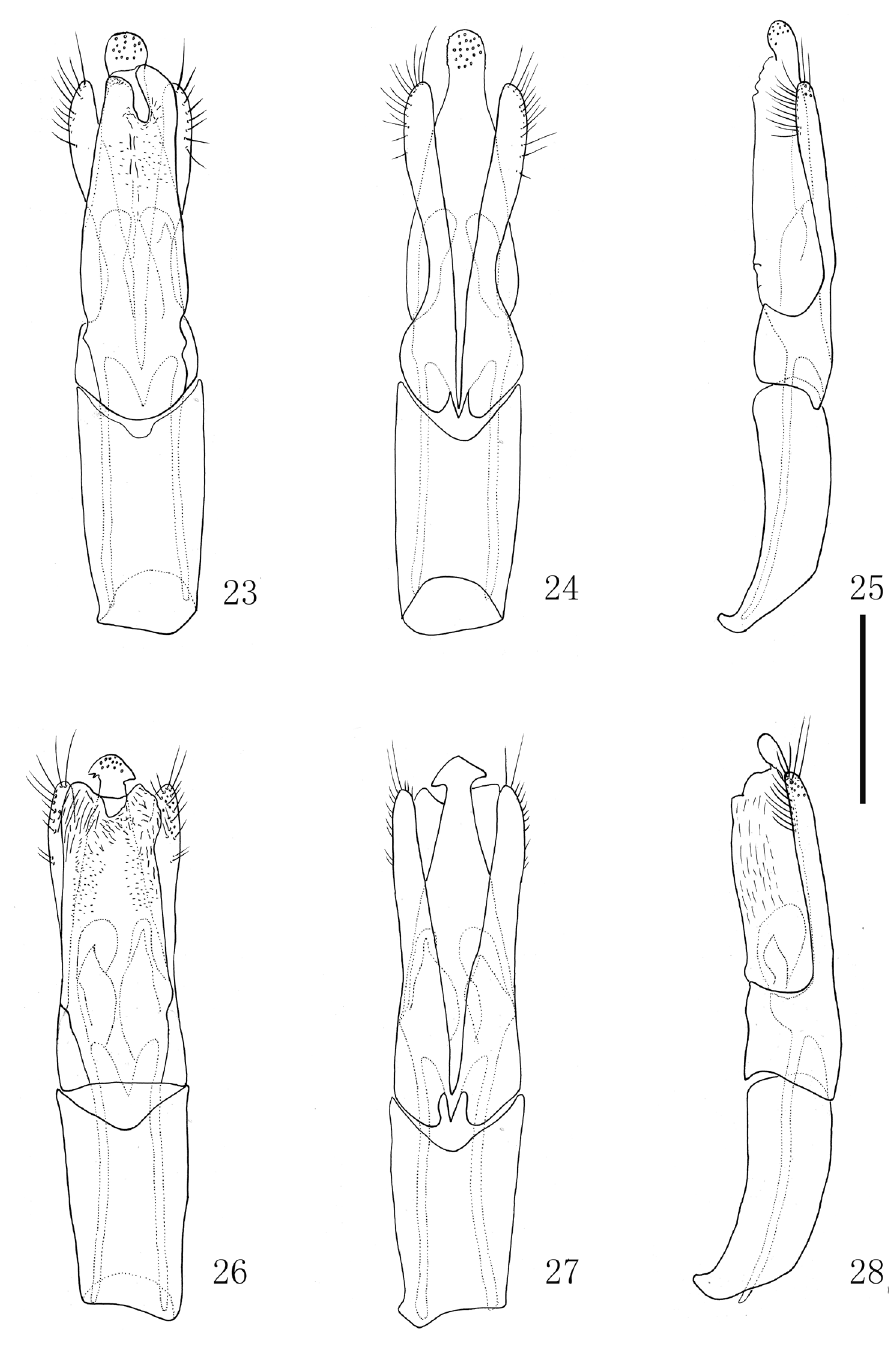
Figures 23–28. Male genitalia. 23–25 Grouvellinus orbiculatus sp. n., holotype 26–28 Grouvellinus sagittatus sp. n., holotype 23, 26 in ventral view 24, 27 in dorsal view; 25, 28 in lateral view. Scale bar: 0.2